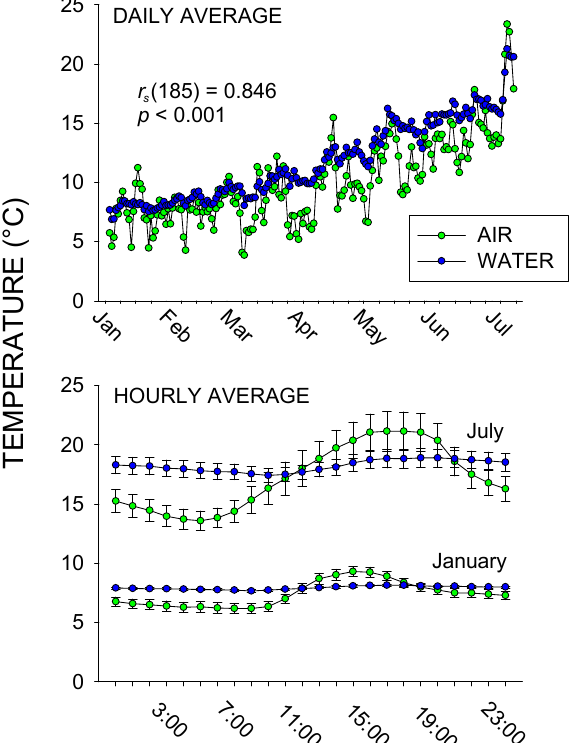
Figure 2. Average daily water and land temperature (top graph) and the average hourly water and land temperature (with standard error of the mean bars [SE]; bottom graph) for January vs. July. The water temperatures are the combined surface + deep water temperatures recorded. Spearman’s r s is reported for the correlation between daily air and water temperatures during the entire study (January–July; n = 187 days).